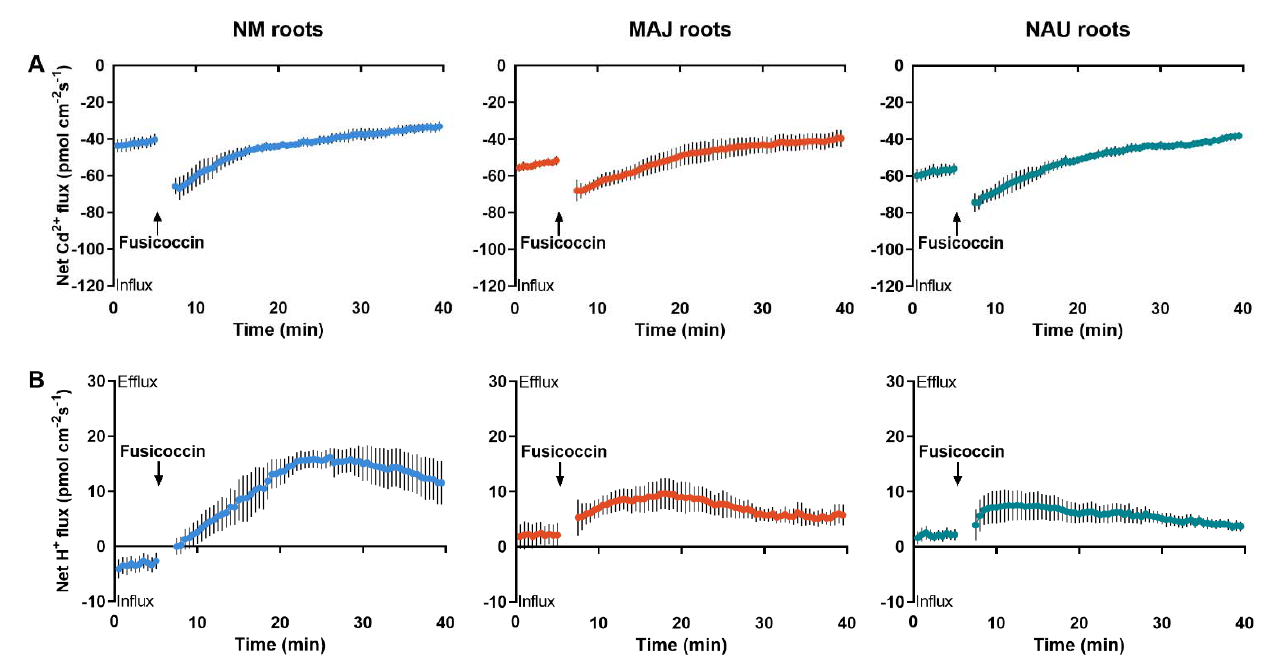
Figure 6. Fusicoccin shock-altered Cd 2+ and H + kinetics in non-mycorrhizal (NM) Populus × canescens and ectomycorrhizal (EM) roots. ( A ) Cd 2+ flux kinetics. ( B ) H + flux kinetics. Poplar plantlets inoculated with or without Paxillus involutus isolates (MAJ or NAU, 30 d) were hydroponically acclimated and subjected to 24 h of CdCl 2 (50 µ M). Root tips were excised from EM- and NM-poplars and equilibrated for 30 min in Cd 2+ or H + measuring solution. At the apical zones, Cd 2+ and H + fluxes were recorded before and after the addition of fusicoccin (10 µ M). The recordings continued, respectively, for 5 and 35 min before and after fusicoccin shock. Each data point is mean ± SD obtained from 5 individual plants.